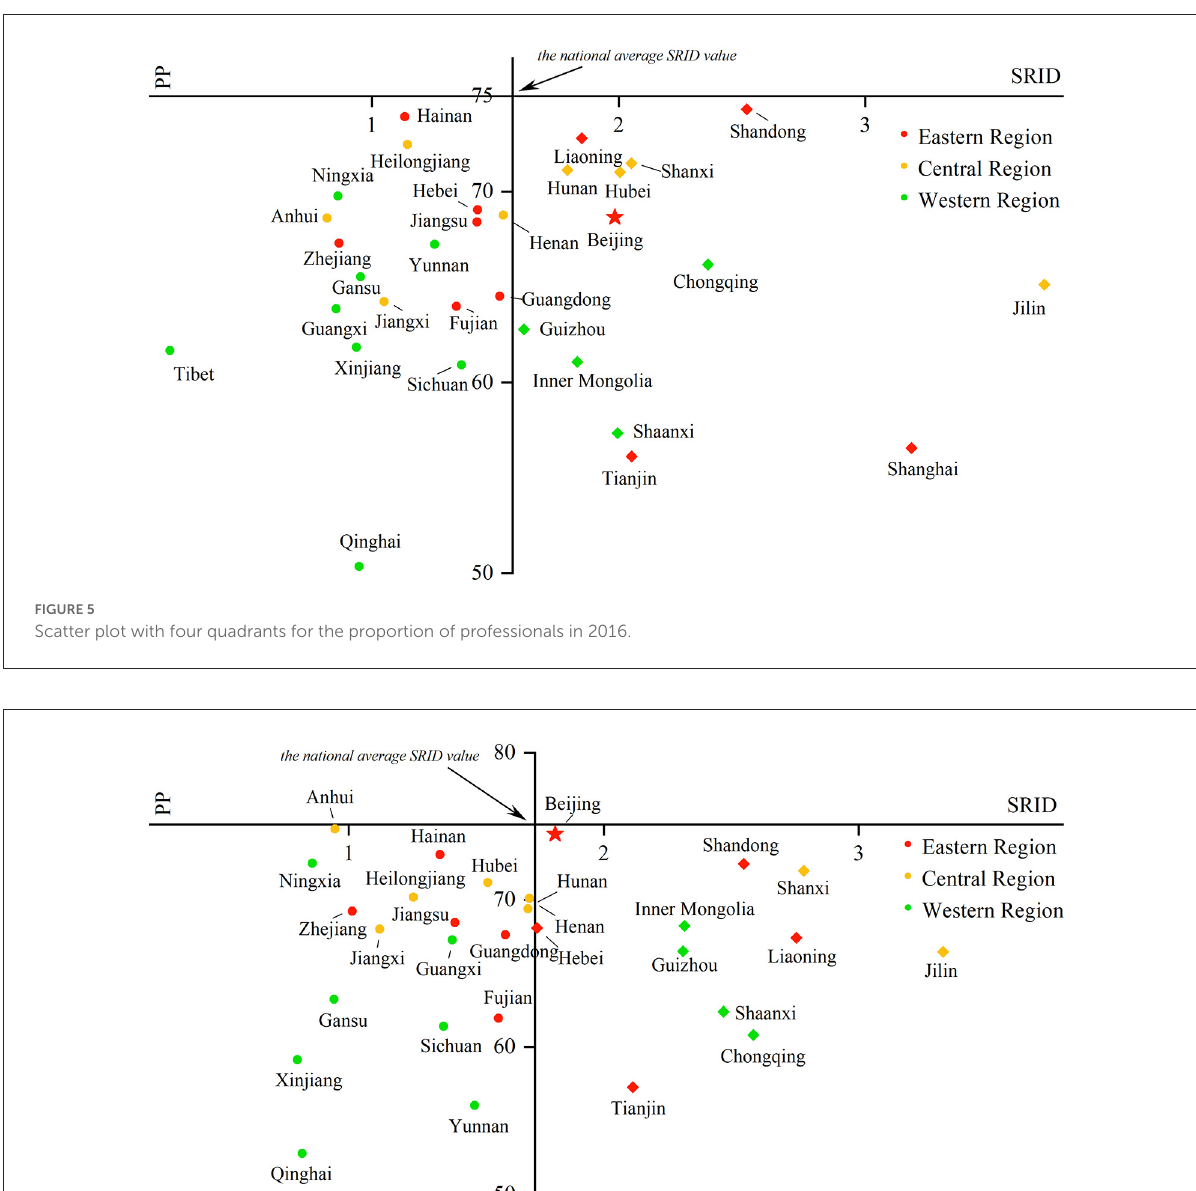
west China, LH type in northeast China (Heilongjiang), and occasionally the HH